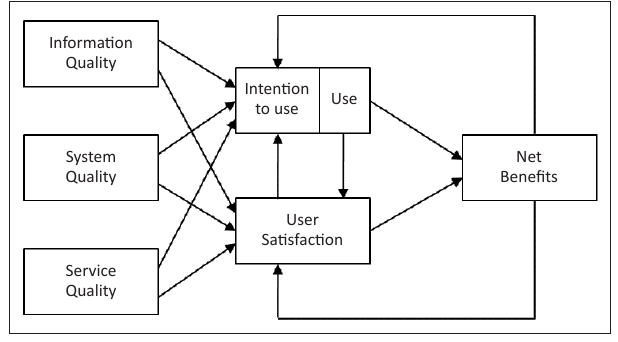
FIGURE 1 : Original D&M IS Success model.